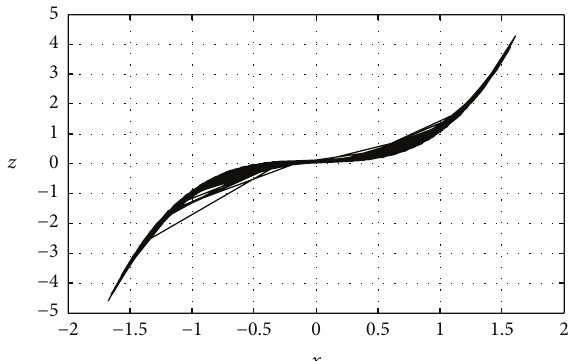
Figure 5: 3D Duffing chaotic system phase diagram in the 𝑥𝑜𝑧 plane projection.